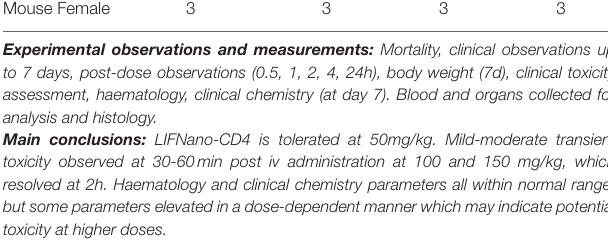
TABLE 1 | hLIFNano-CD4: Single Ascending Dose Preclinical Toxicity Trial: Mouse. GROUP